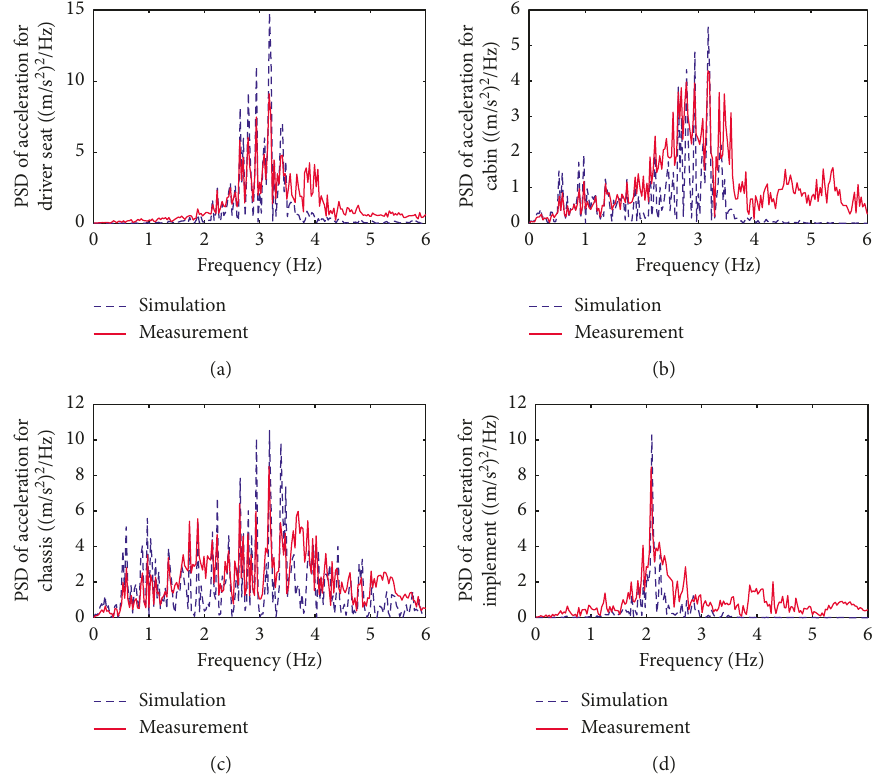
Figure 11: PSD of acceleration for the tractor/implement system: (a) driver seat; (b) cabin; (c) chassis; (d)